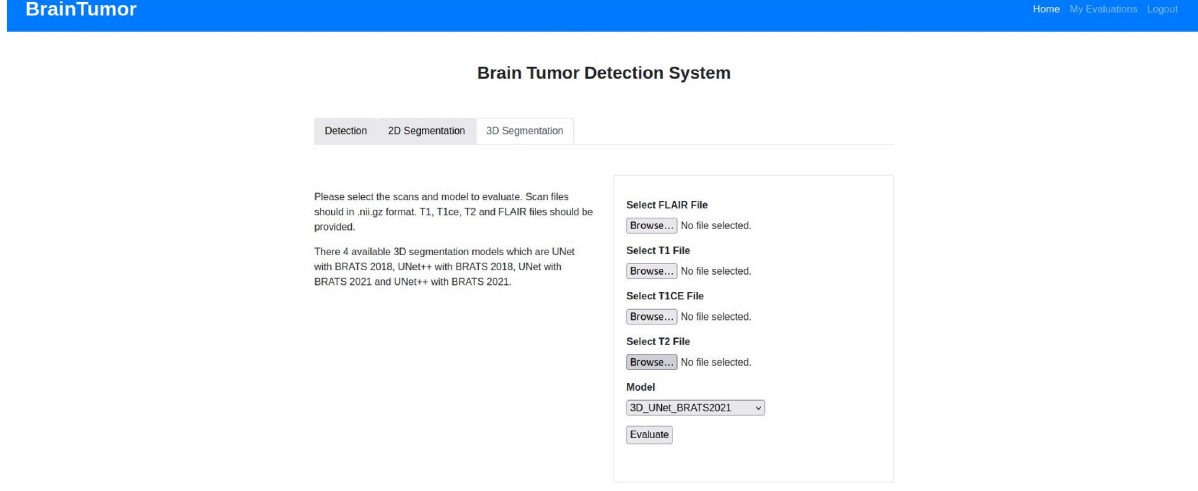
Fig 19. 3D segmentation